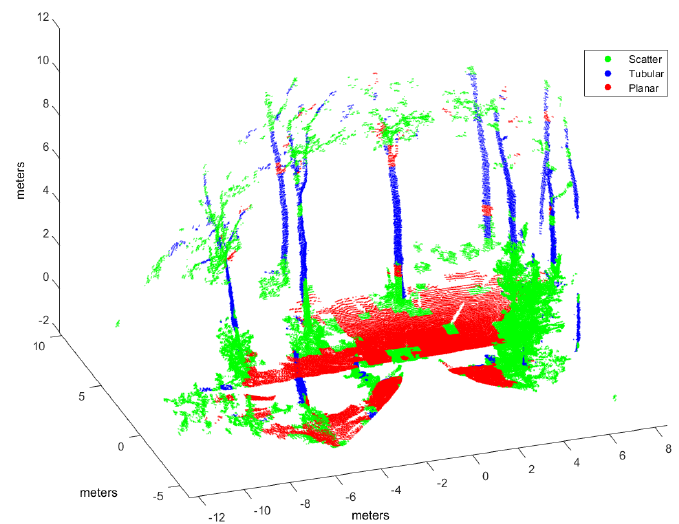
Figure 8. Natural_2 point cloud classified by NN with F 2